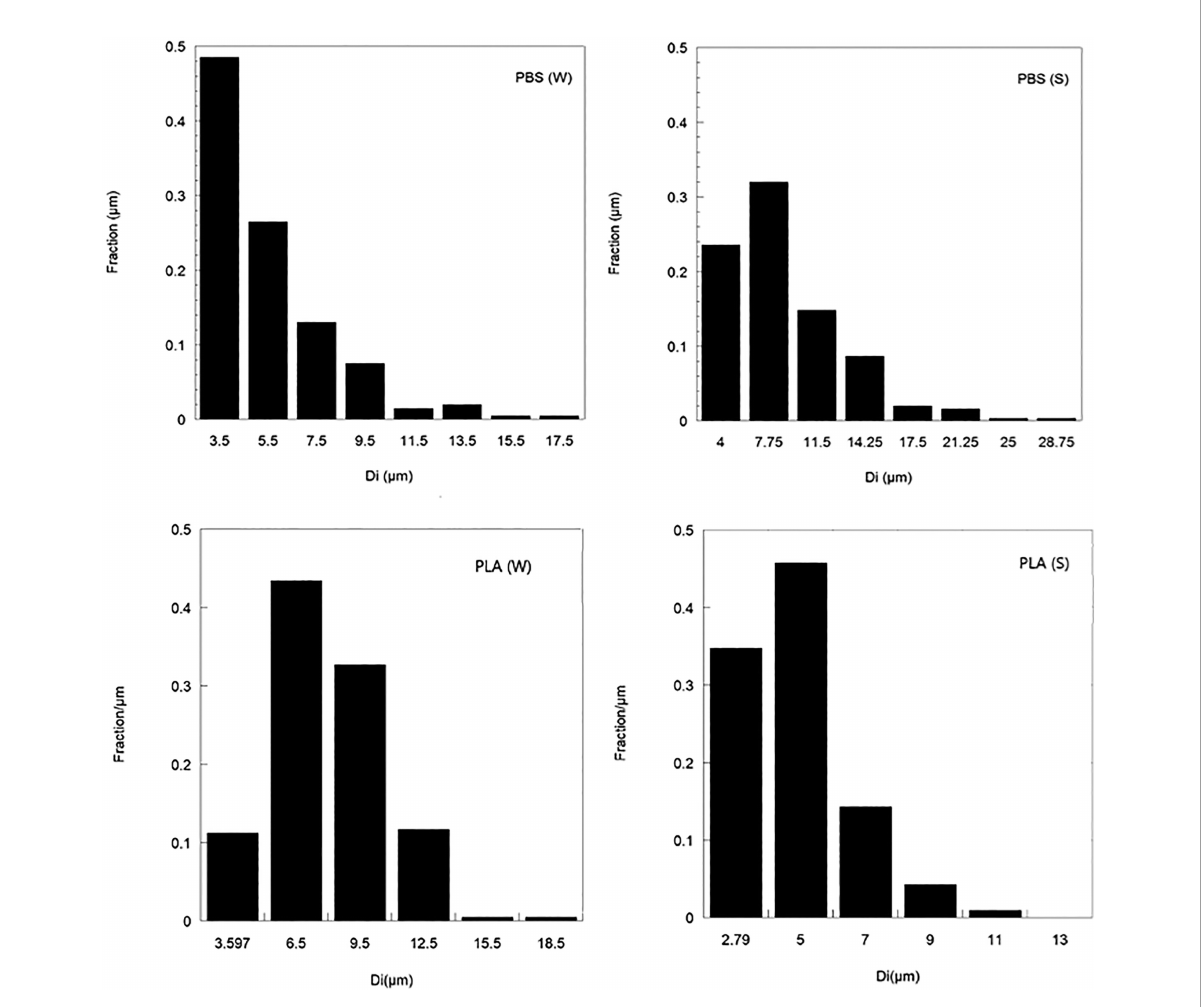
FIGURE 3 Particle size distribution of microplastics that were fl oated on the seawater surface (W) and submerged in the sand under the seawater (S) after